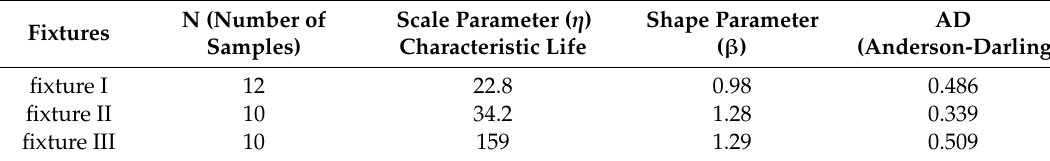
Figure 8. Weibull distribution of the drops to failure for BGA packages ② with various fixtures. Table 2. Analysis of the Weibull distribution plot for BGA package ② .